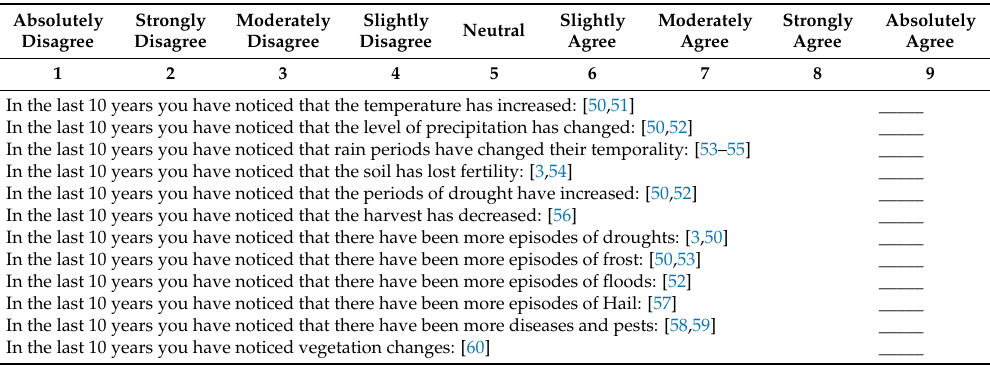
Table 4. Items included analyzing the farmers’ perceptions of climate